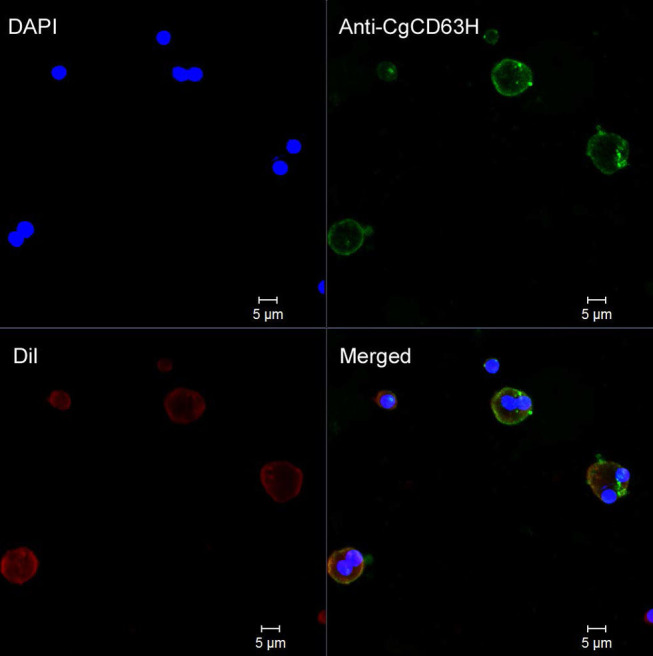
Subcellular localization of CgCD63H protein in oyster hemocytes. Binding of antibody to CgCD63H was visualized by Alexa 488-labeled secondary antibody (green); the nucleus of hemocytes was stained with DAPI (blue), bar = 5 μm.